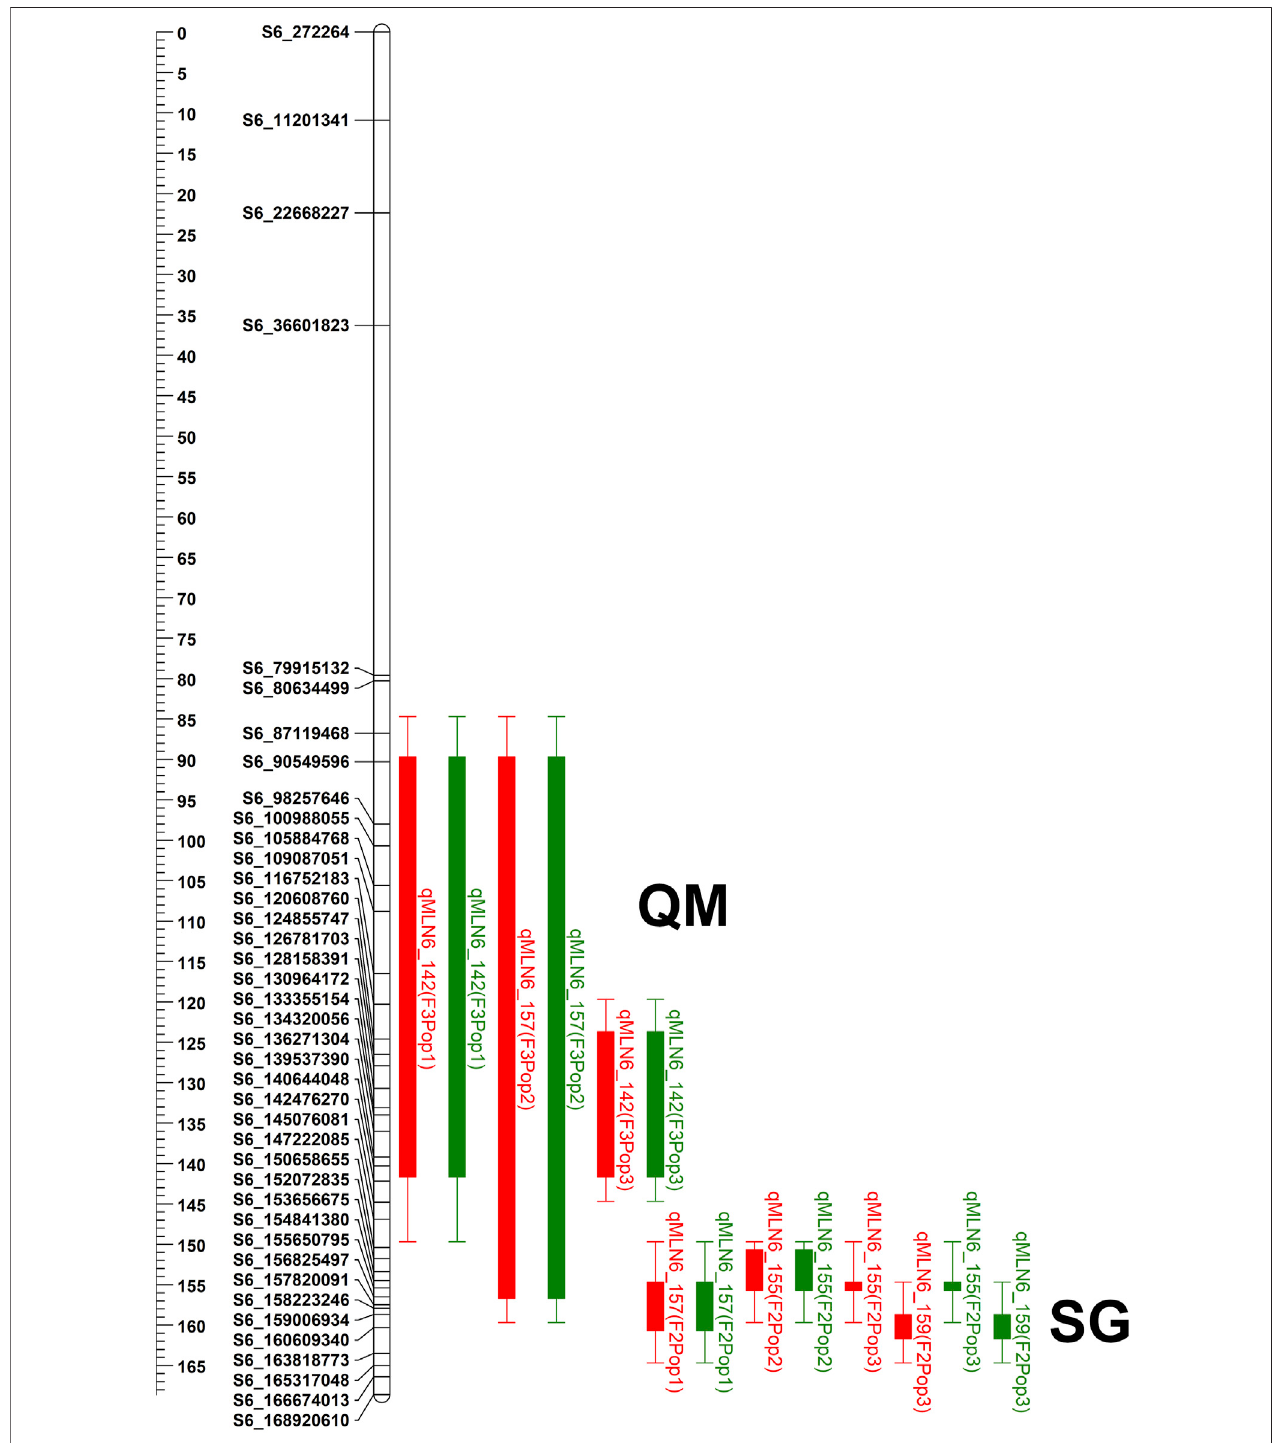
FIGURE 2 | The physical positions of the QTL detected on chromosome 6 in all three F3 QTL mapping (QM) populations and three F2 selective genotyping (SG) populations.QTLbarwithredcolorrepresentsforMLN_DSandgreenbarrepresentsQTLforAUDPCvalue.QTLnamewascomposedbythetraitcodefollowedbythe chromosome number in which the QTL was mapped and a physical position of the QTL.